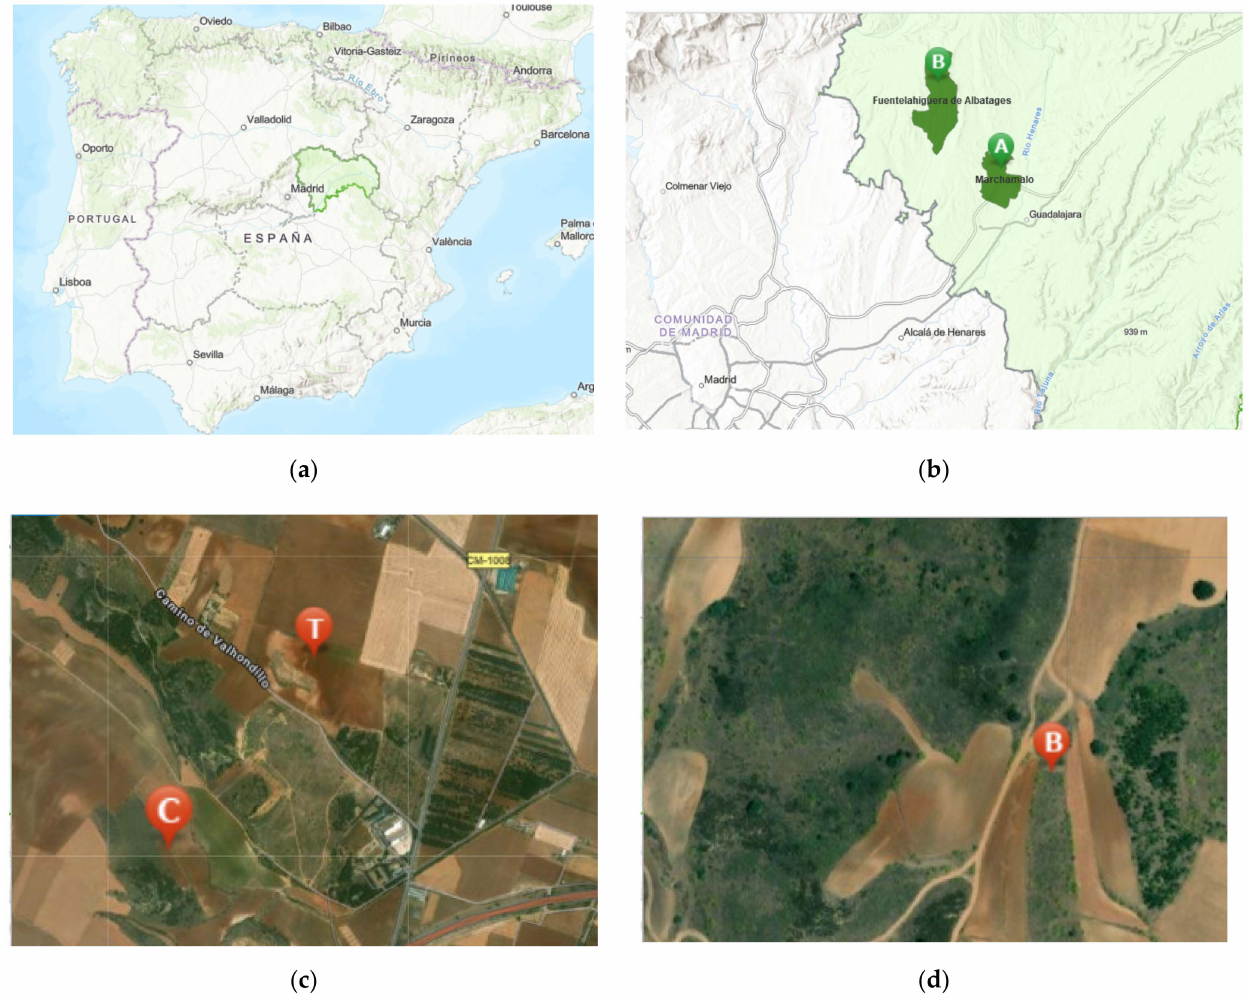
Figure 1. Site of the experimental study: ( a ) Map of Spain with the Province of Guadalajara high- lighted in green; ( b ) Location of the apiaries during (A: Marchamalo) and after (B: Fuentelahiguera de Albatages) the exposure phase; ( c ) Detailed location of the apiaries during the exposure period in Marchamalo (C: control, T: treatment); ( d ) Detailed location of the apiaries after the exposure period in Fuentelahiguera de Albatages